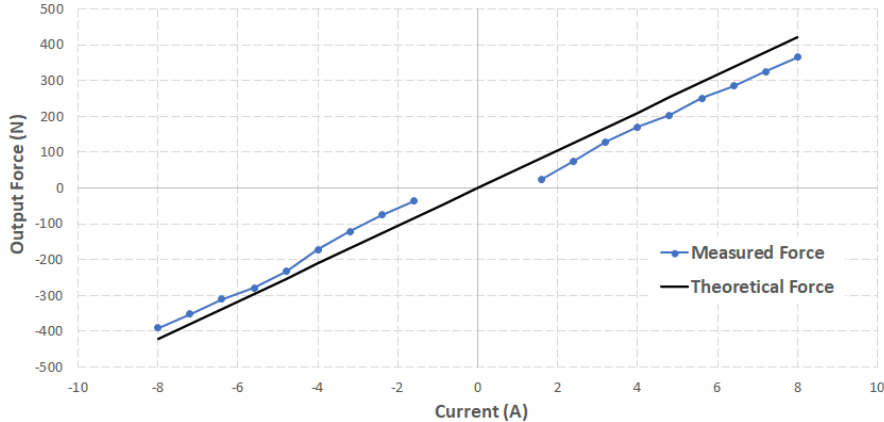
Figure 8. Measured and theoretically calculated output forces of the B-SALD prototype.